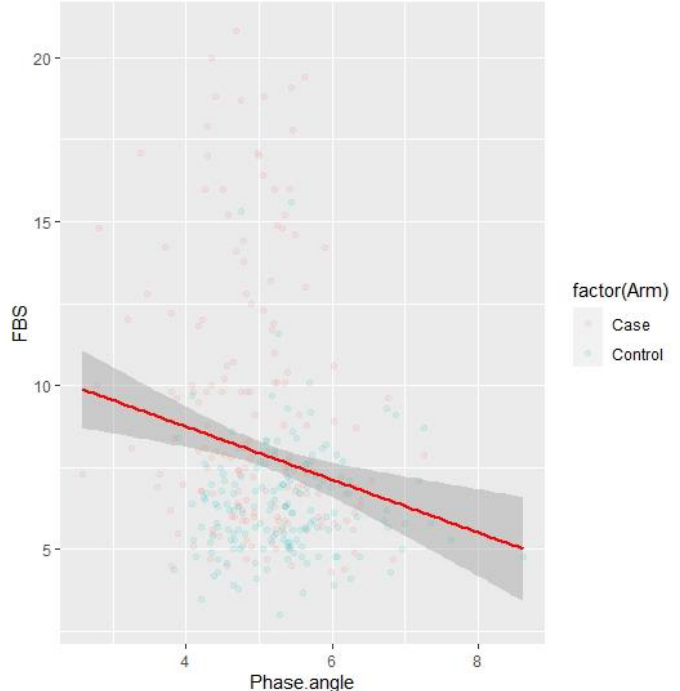
Figure 1. Correlation between Phase Angle and Fasting blood glucose among cases and controls.